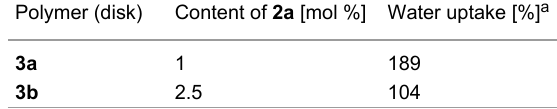
Table 1: Water uptake of cross-linked polymers 3a and 3b . Polymer